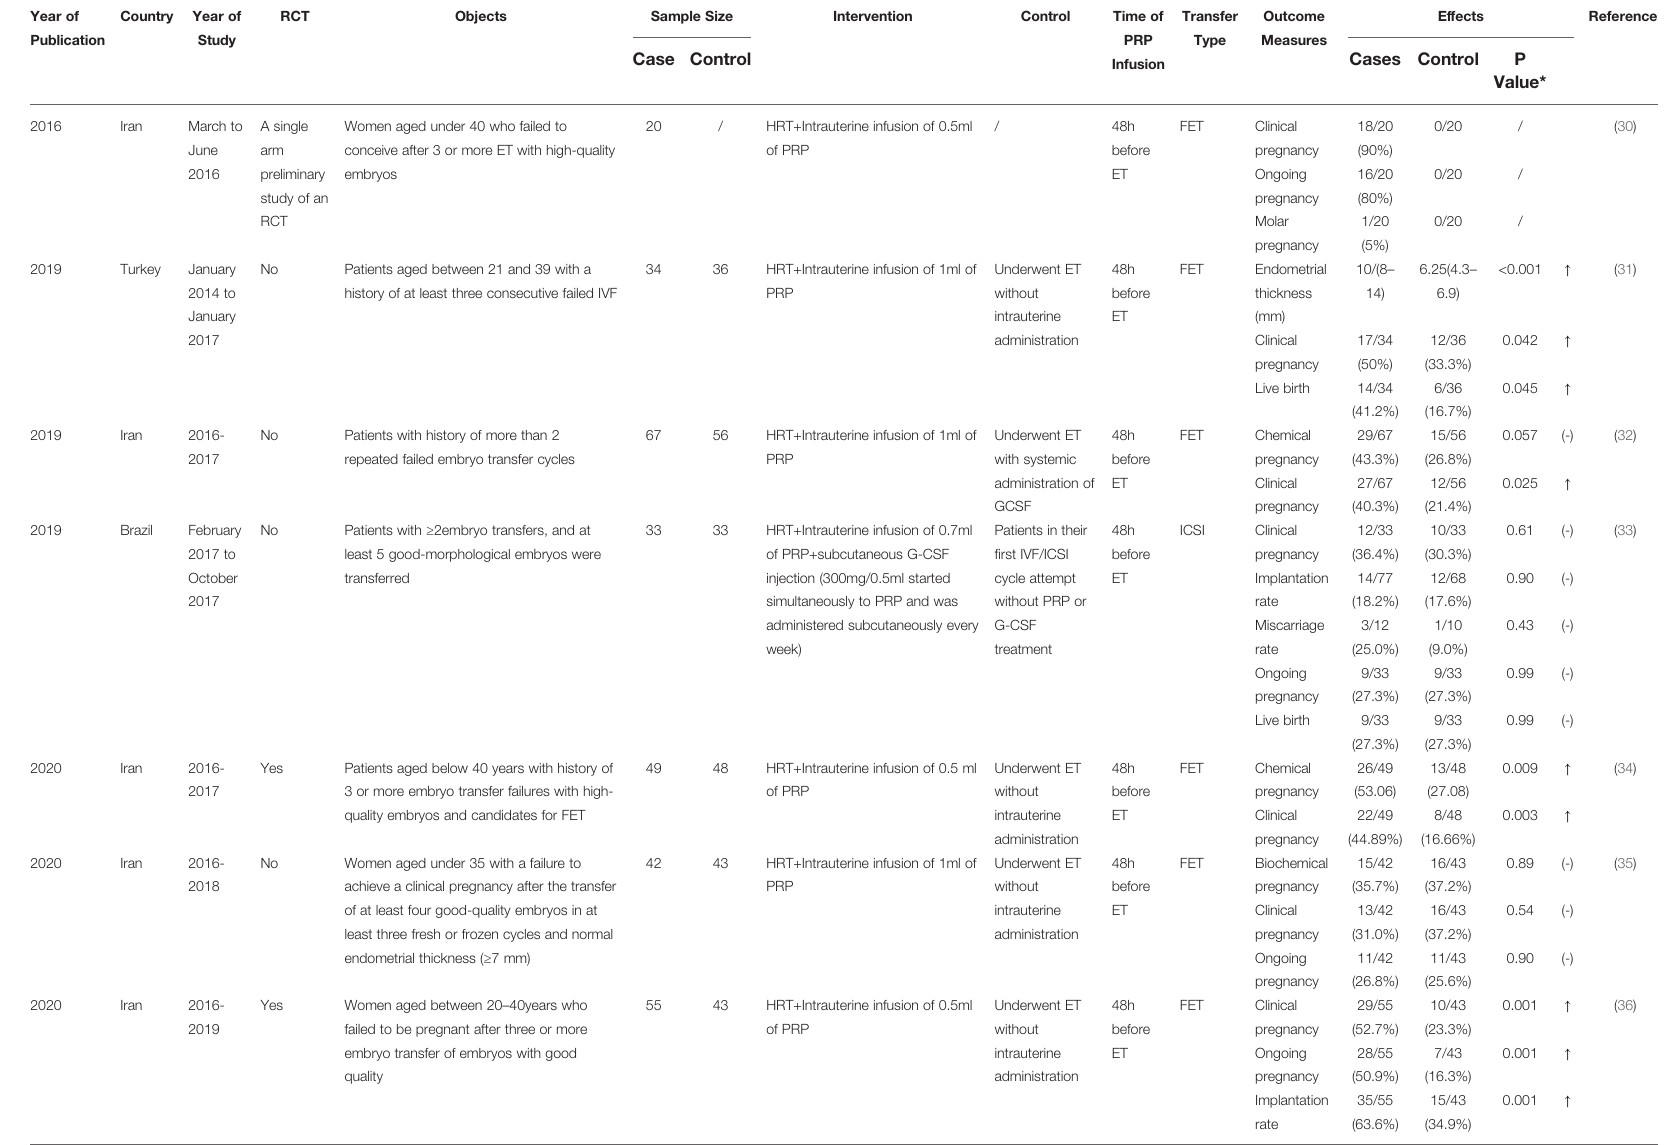
TABLE 2 | Studies assessing the effect of platelet-rich plasma (PRP) treatment in repeated implantation failure (RIF) patients in vitro fertilization. Year of Country Year of Publication Study